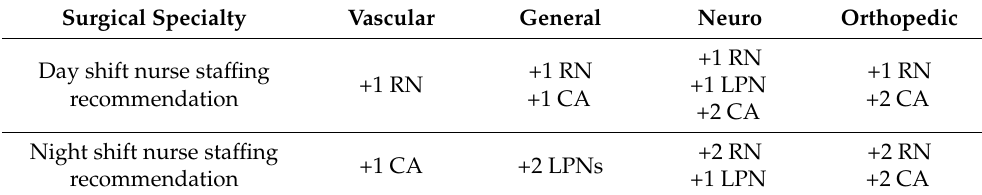
Table 4. Nurse staffing recommendations informed by Synergy scores.